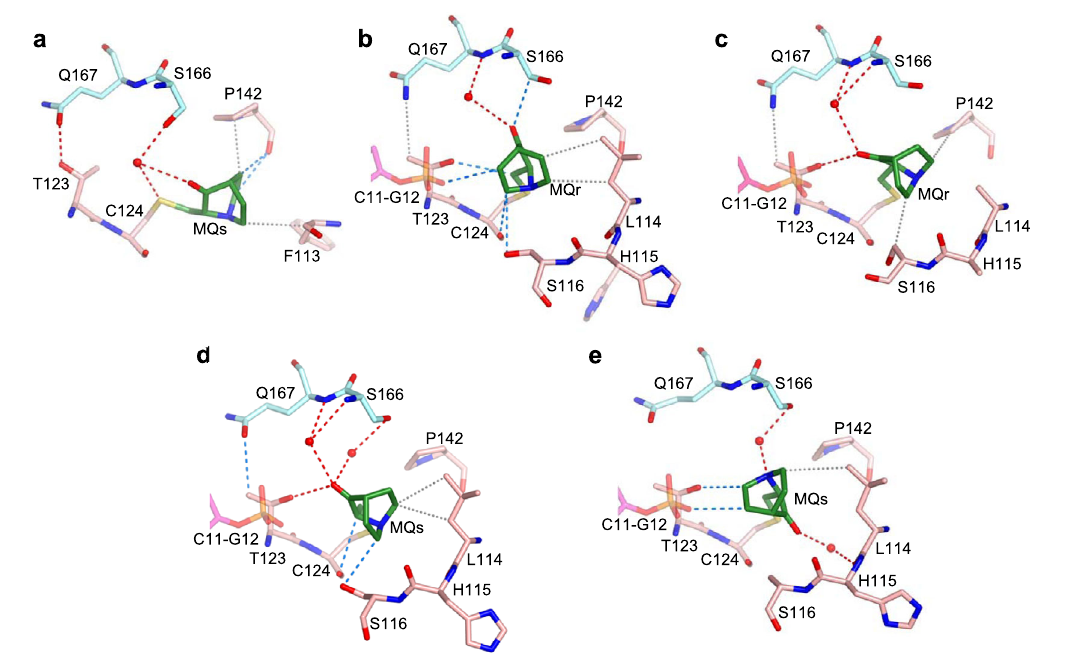
Fig. 7 MQ bound to C124 in p53-DNA complexes. The MQ-C124 conjugates and associated intra- and intermolecular interactions are based on the following structures. a R282W-DNA-MQ. b R273C/S240R-DNA-MQ. c wt-DNA-MQ (I). d wt-DNA-MQ (II). e wt-DNA-MQ (III). MQ-C124 is located at the C-terminus of the fl exible L1 loop (residues 113 – 124). R282W-DNA-MQ differs largely from the other four structures by the orientation and position of the bound MQ (see text for details). The structures are in stick representation with the following color codes: C atoms shown in green for MQ, pink for the MQ-modi fi ed p53 monomers and light blue for the neighboring monomers. N, O, S and P atoms are in blue, red, yellow and orange, respectively. Hydrogen bonds, CH···O and VdW interactions shown in red, blue and grey dotted lines, respectively, and water molecules shown as red